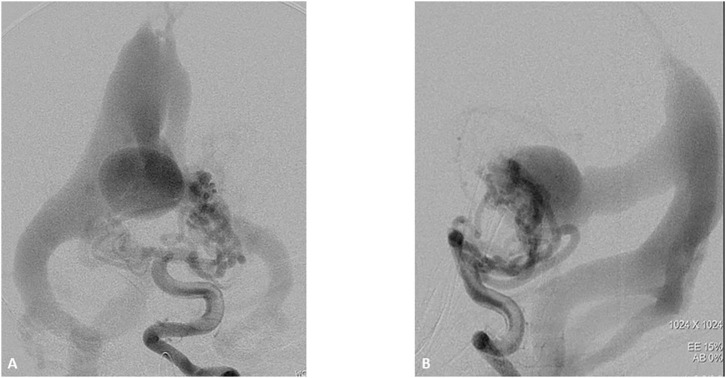
One-month boy presented with severe high failure requiring pressors and ICU management. Initial ultrasound through the frontal fontanelle showed concerns for a vein of Galen malformation. A vertebral DSA AP (A) and lateral (B) views reveal a high flow vein of Galen choroidal malformation with enlarged choroidal feeders of the posterior cerebral artery, left greater than right. These fistulae drain into a dilated vein of Galen and median vein of the prosencephalon. There is filling of the bilateral transverse sigmoid sinuses, right greater than left as well as some opacification of the occipital.